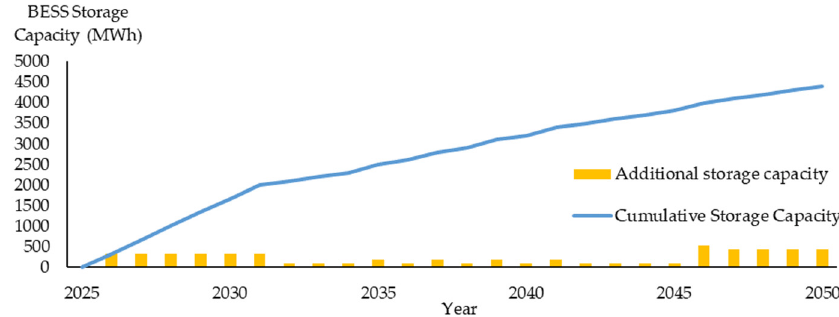
Figure 6. Additional and cumulative BESS storage